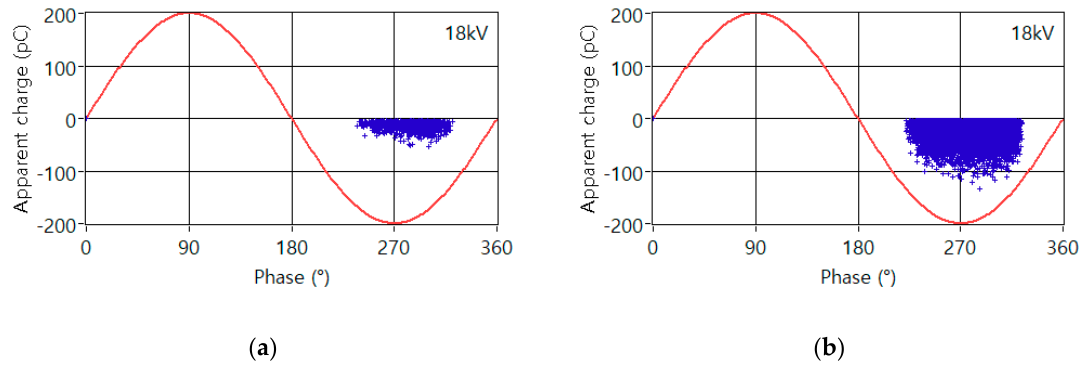
Figure A2. PRPD patterns in the POE. ( a ) In SF 6 ; ( b ) In g3.